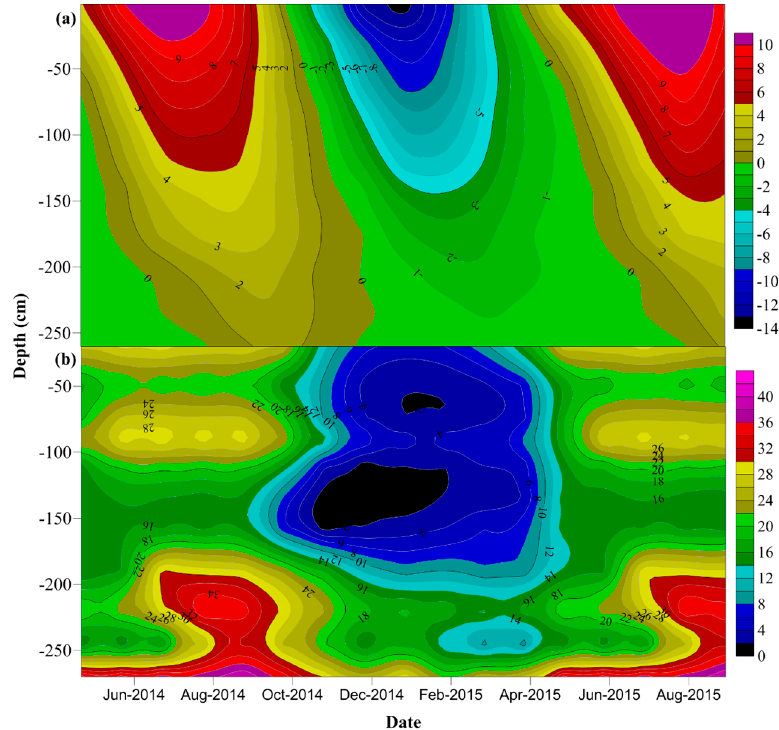
Figure 5. Spatiotemporal distribution of soil temperature and moisture contents in the slope: ( a ) Soil temperature (°C); and ( b ) volumetric water content (%).